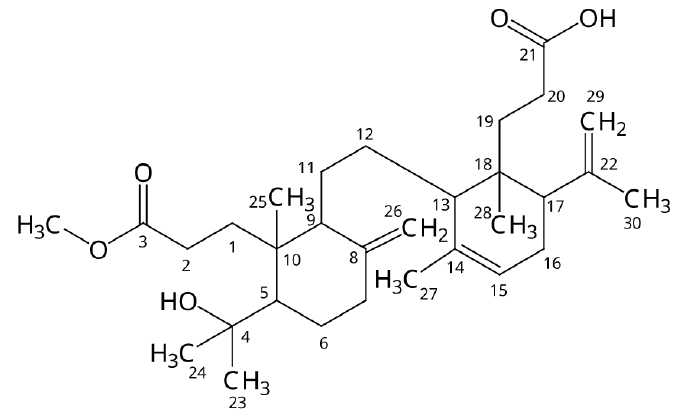
Figure 2. Isolated compound 1, Lamesticumin A.